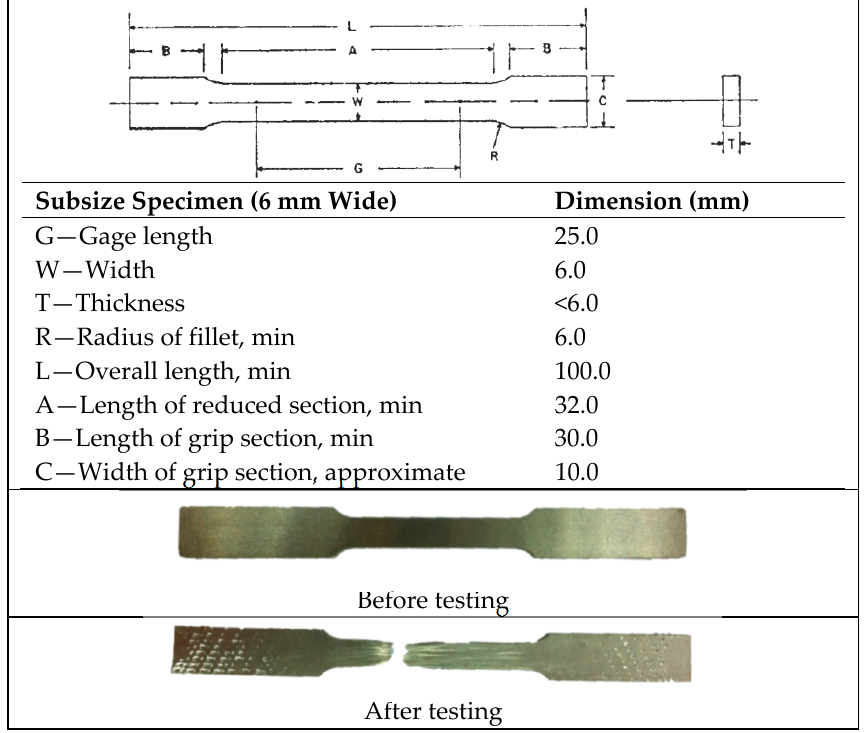
Figure 3. Tensile specimen dimension after recycled process.